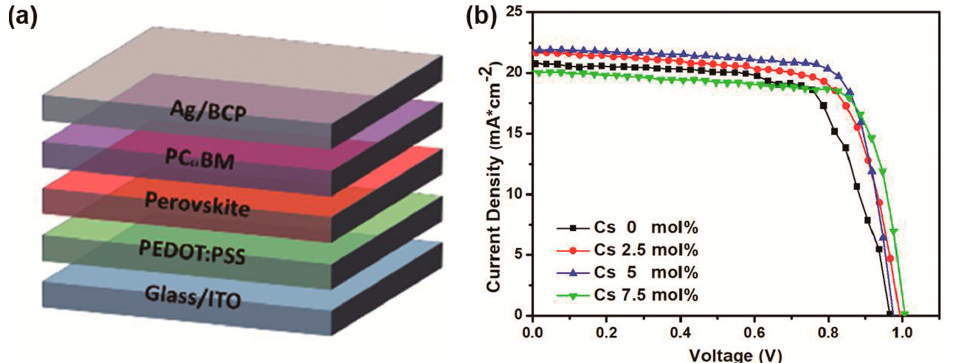
Figure 1. ( a ) Perovskite solar cell structure. ( b ) Current density–voltage (J–V) characteristics of the MAPbI3 PSCs with different cesium doping concentration. Table 1. Average photovoltaic parameters of the MAPbI 3 PSCs based on perovskite precursors with 0 mol%, 2.5 mol%, 5.0 mol%, and 7.5 mol% cesium doping. Cesium Doping Con- centration (mol%).